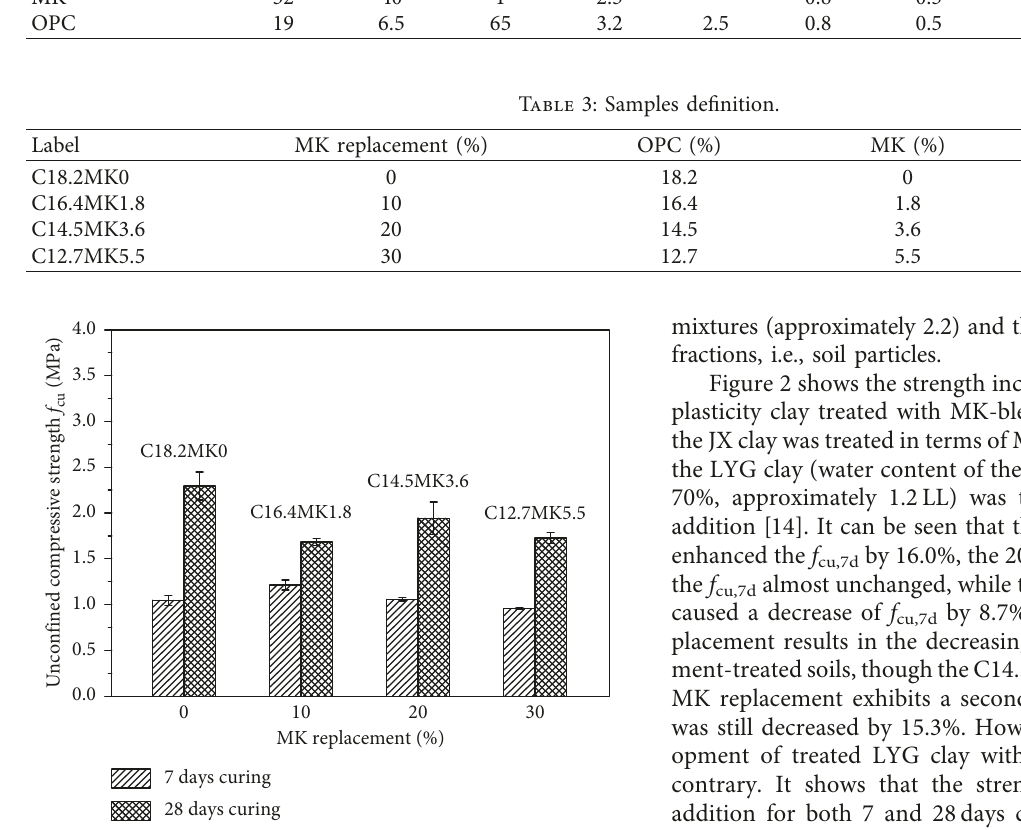
Figure 1: Unconfined compressive strength of the MK-blended cement-treated